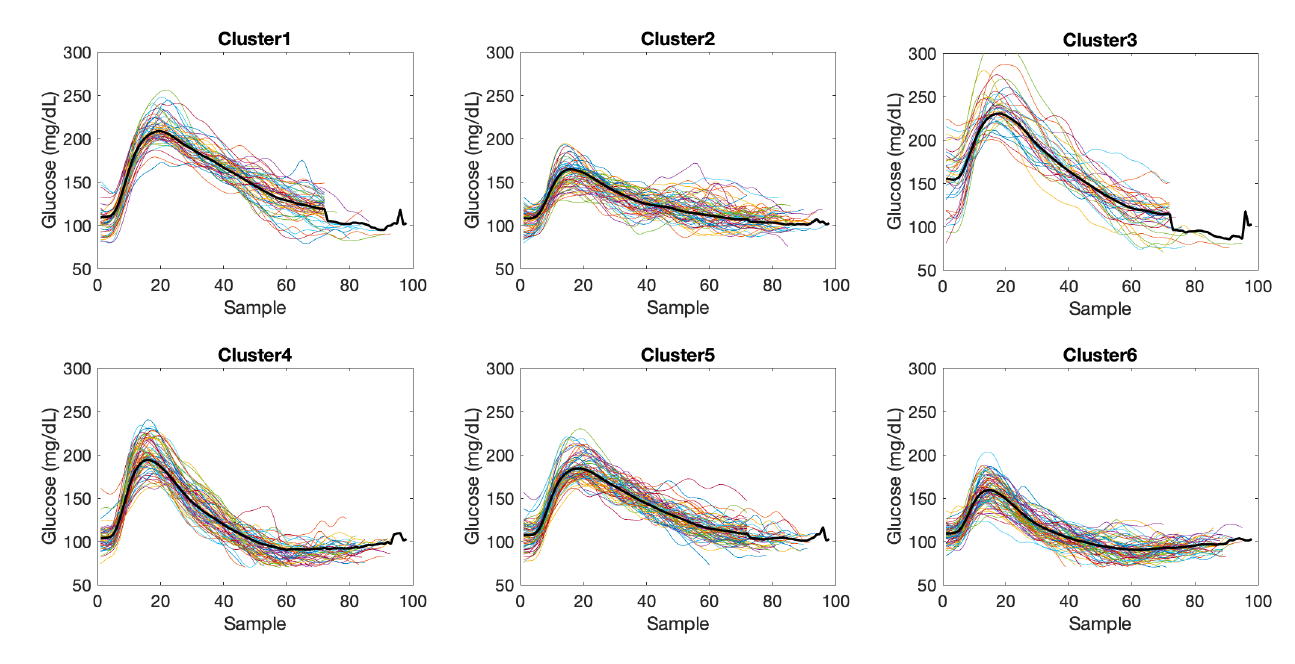
As an illustration, Figure 5 shows the clustering results for patient 6 and data in the meals partition Π M . The number of elements per cluster were 50, 61, 36, 63, 70 and 71 for clusters 1 to 6, respectively. Regularized length of the time subseries was 98. Considering the whole cohort, regularized lengths ranged from 98 to 106 samples for Π M , from 60 to 65 samples for Π N , and from 36 to 76 samples for Π H .